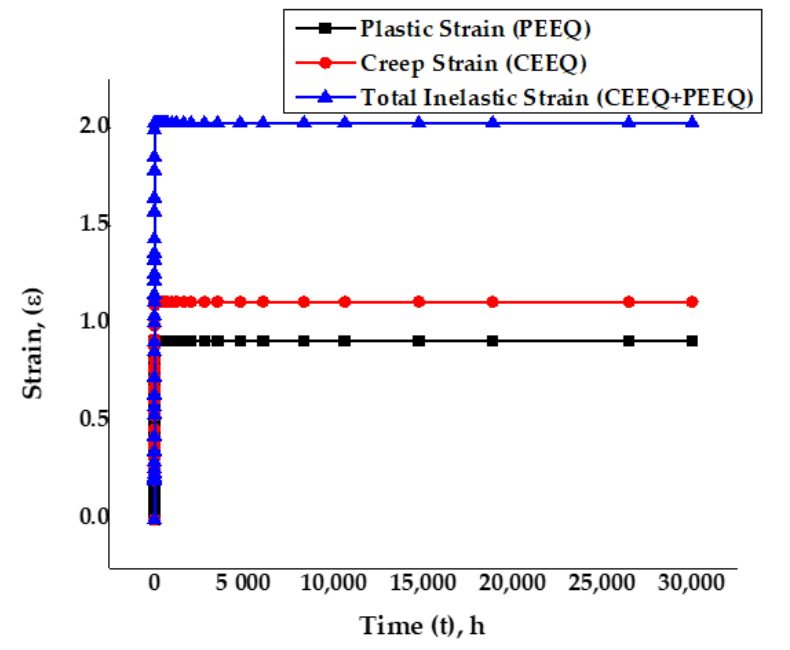
Figure 12. Accumulated creep strain and plastic strain for the dog bone coupon SS-316.